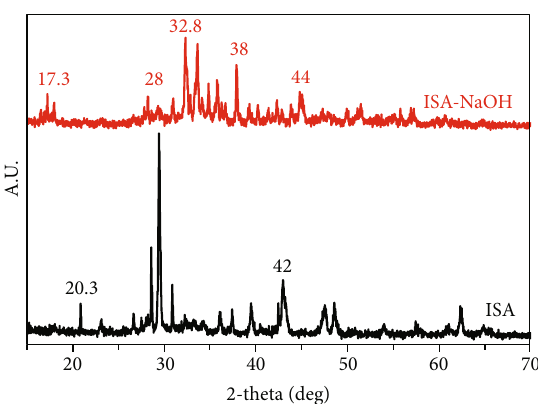
Figure 3: XRD di ff ract graph of ISA and sintered